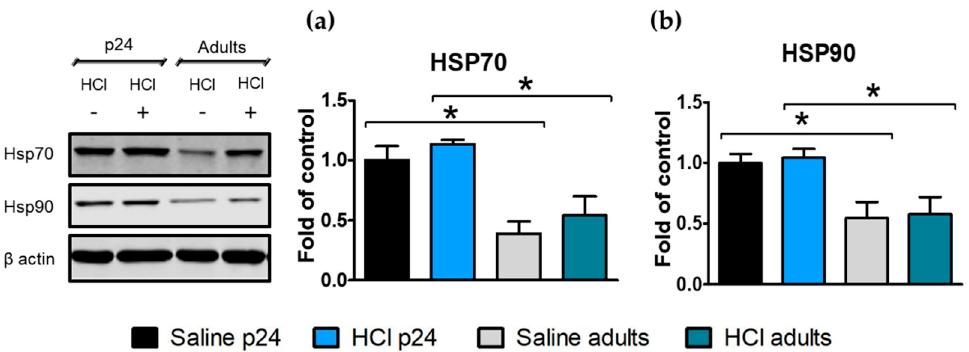
Figure 4. Age-dependent expression of heat shock proteins in the lung. ( a , b ) Young control mice express higher concentrations of HSP70 and HSP90 than the adult control mice. No differences were observed 30 days after HCl instillation. Histograms represent the quantification of the blots. Means ± SEM, n = 3–4, * p < 0.05; with one-way ANOVA and Tukey’s test.